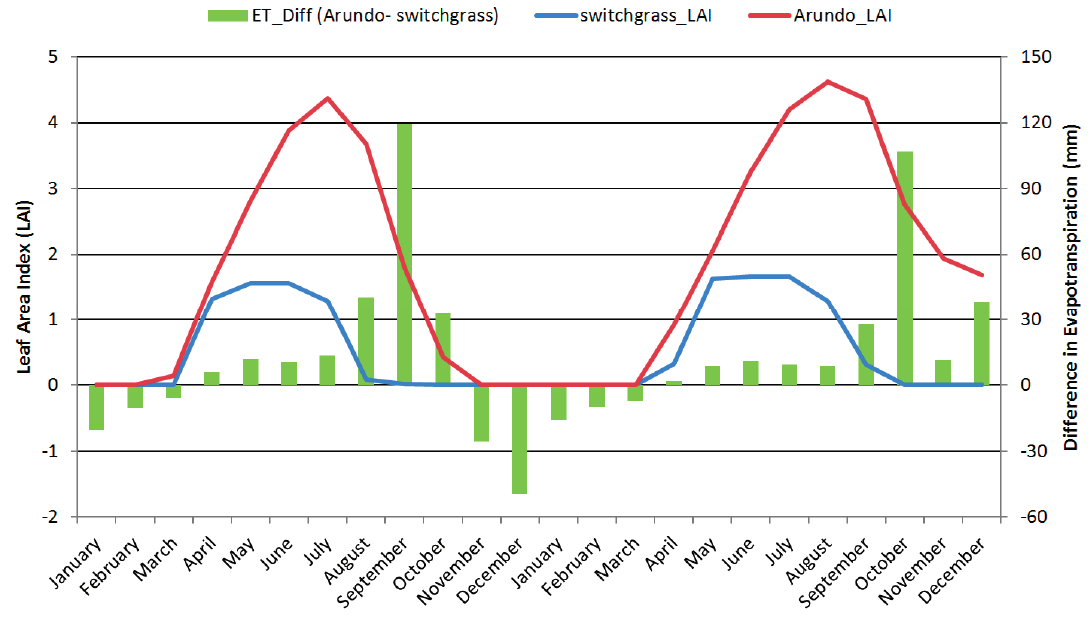
Figure 3. Comparison of simulated annual Arundo and switchgrass evapotranspiration.